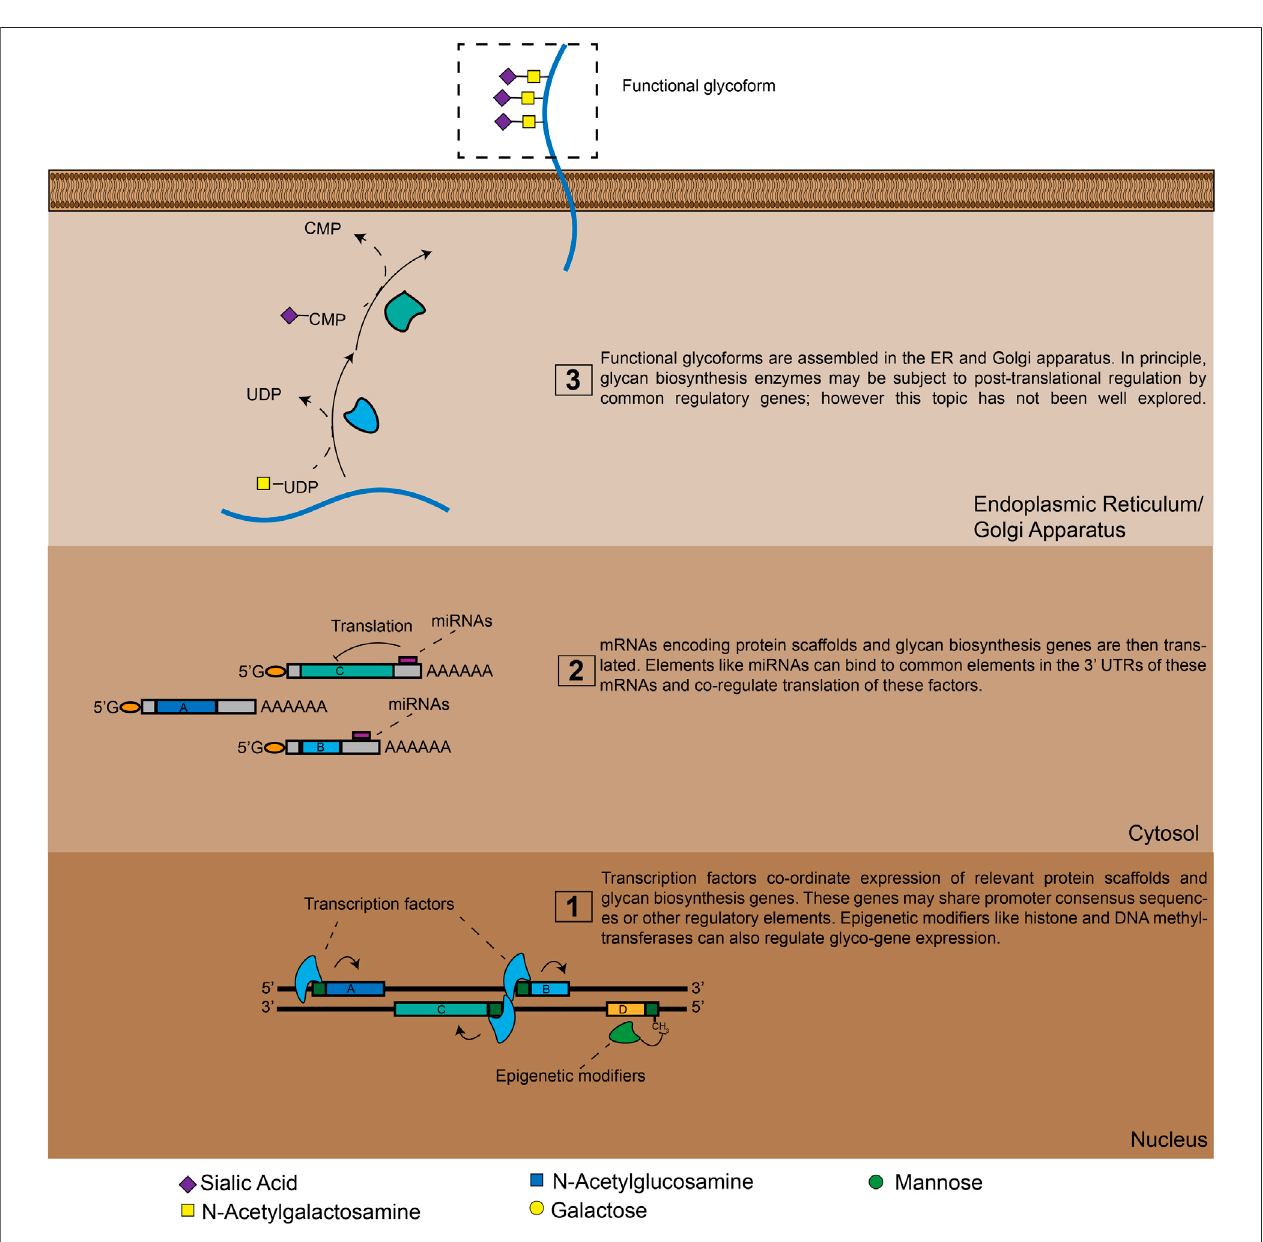
FIGURE1| Ahigh-levelviewofglyco-genomicregulation.Cell-surfaceglycosylationpatternsemergefromtheexpressionand/orrepressionofmanyenzymes.TFs andepigeneticmodi fi erscanco-ordinatethesepolygeneticcircuitsatthetranscriptionallevel,whilemiRNAsdosoatthetranslationallevel.Additionallayersofregulation are also possible, meaning that a cell ’ s glycomic state can only be imperfectly predicted by analyzing mRNA and miRNA expression levels.